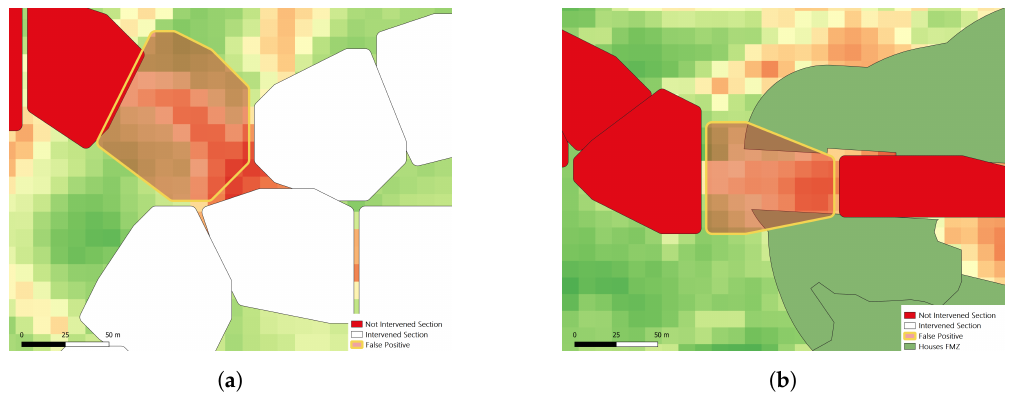
Figure 12. Examples of false positives obtained using the SVM with the data set DS_BAND